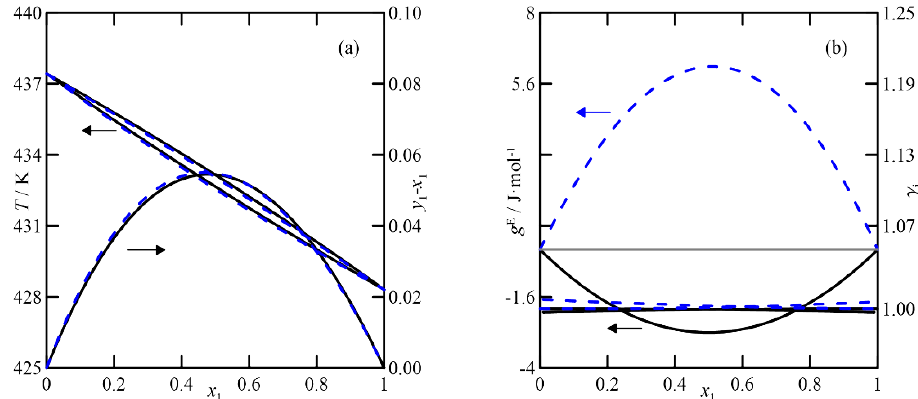
Figure 6. Estimations of VLE at 101.32 kPa of cyclohexanone + 2-methylcyclohexanone. (—-) UNIFAC-DM; (- - -) COSMO-RS. ( a ) T ,x,y and (y − x ), x ( b ) γ i vs x and g E / RT vs x . (iii/iv) Cyclohexanone + (2 or 3)-cyclohexen-1-ol: The VLEs of cyclohexanone